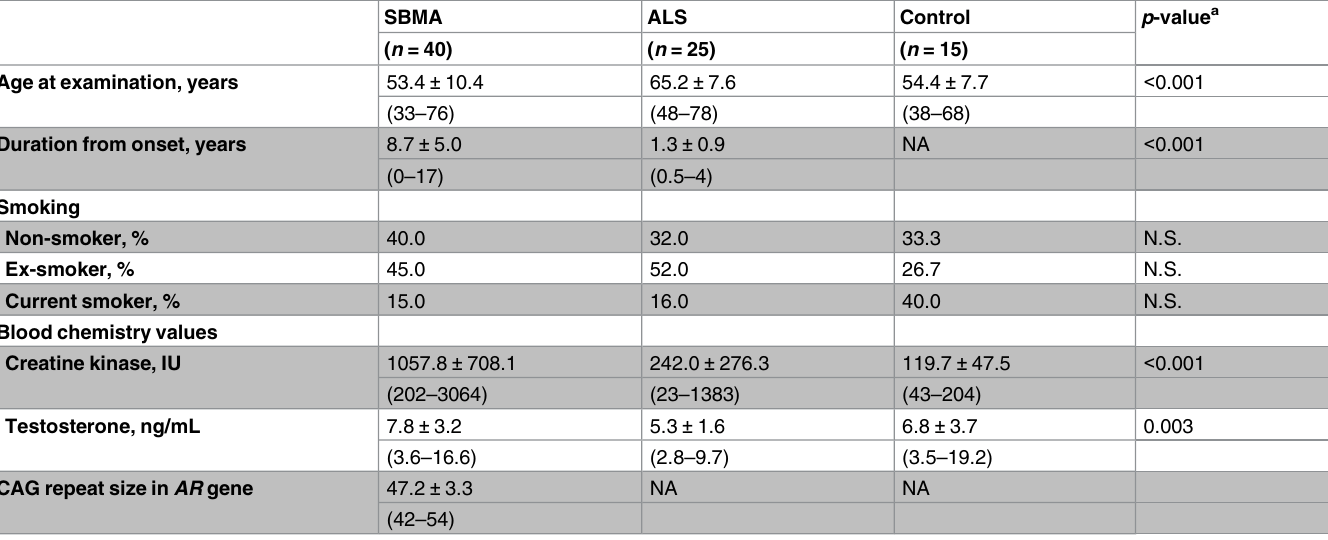
Table 1. Clinical background of